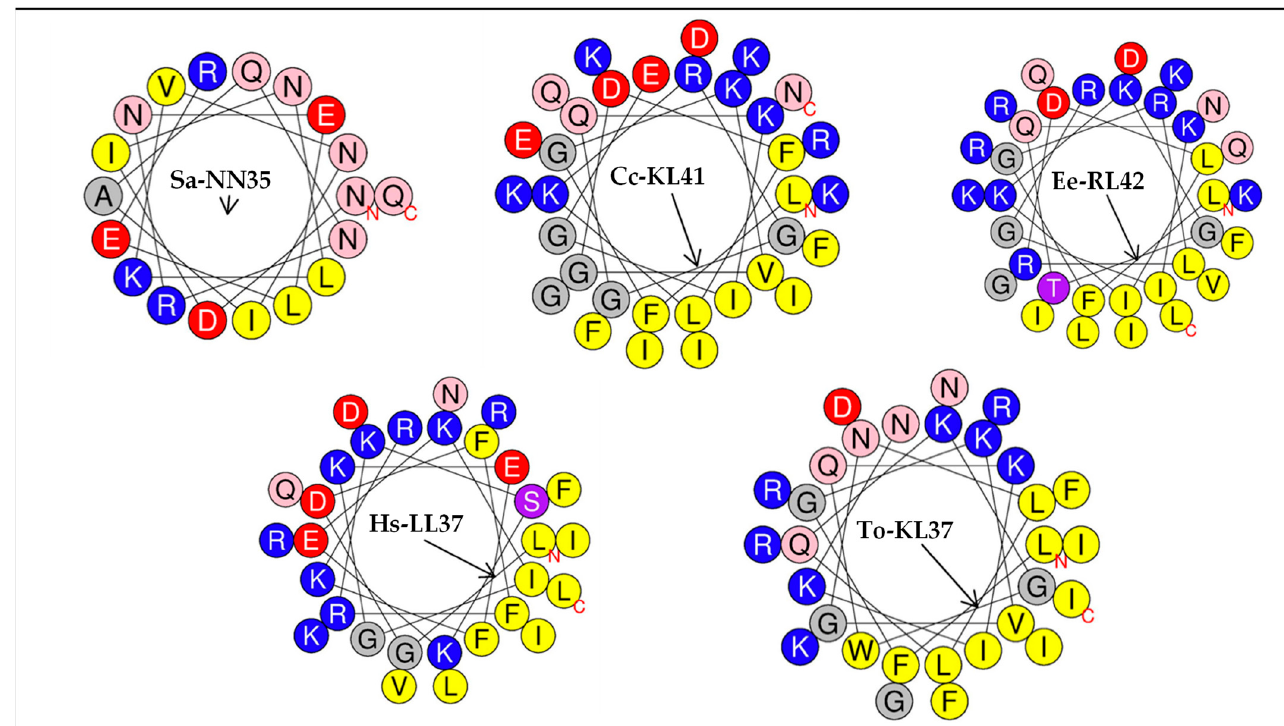
Figure 6. Helical wheel projection by Edmonson of alpha helices included in the putative antimi- crobial peptides from the annotated cathelicidins of the Eulipotyphla order, encompassing Talpa occidentalis . Residues in yellow are hydrophobic, whereas residues colored in blue are cationic. Polar acidic residues (D and E) are colored in red, amine group-containing residues (N and Q) are colored in pink, hydroxi-amino acids (S and T) are colored in purple, and glycine residues are colored in grey. The arrow indicates the orientation of the hydrophobic moment <µH>. The human cathelicidin peptide Hs-LL37 was used as a reference.